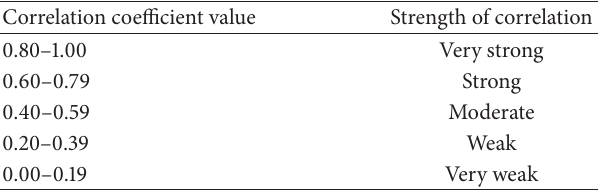
Figure 8: Exact match-SVM. Table 6: Evans correlation coefficient classification.